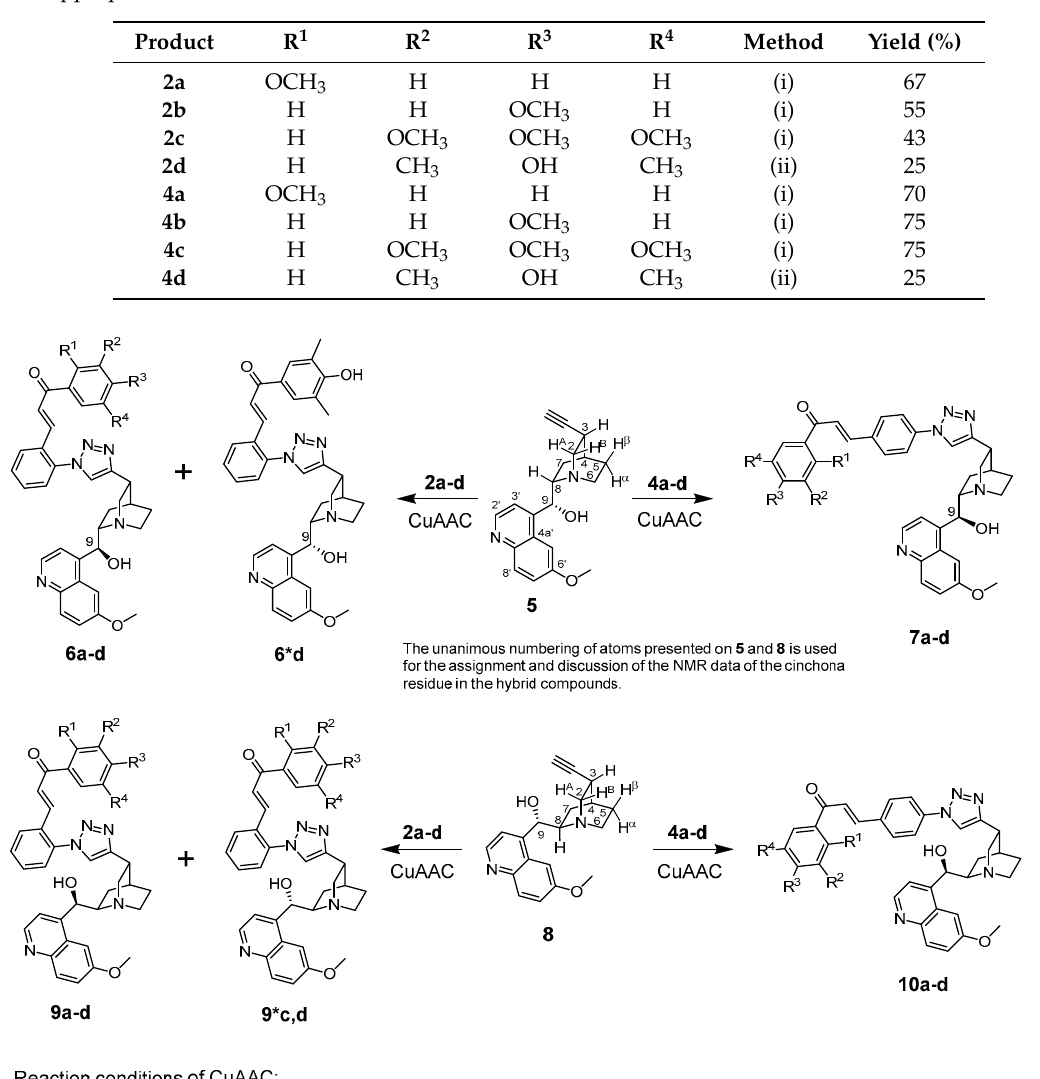
Table 1. Designation and isolated yields of azidochalcones 2a – d and 4a – d prepared by the appropriate method.